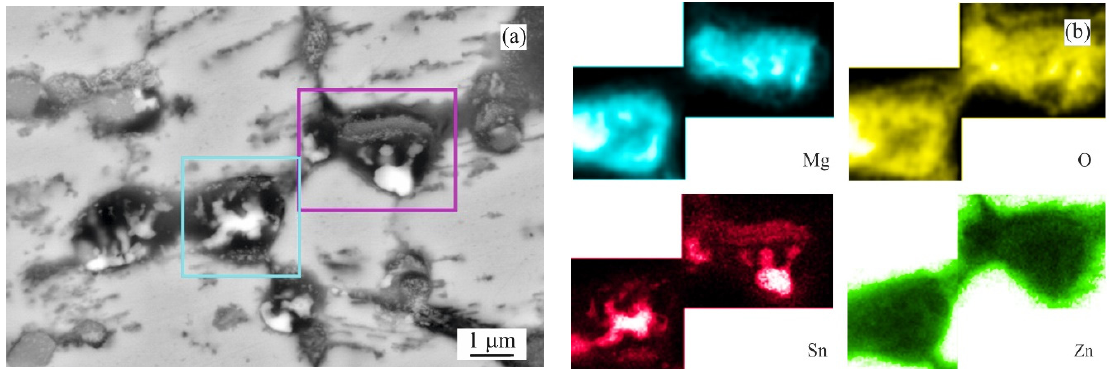
Figure 15. Details of Mg 2 Sn particles affected by dealloying (MZ + 3.0Sn, annealed): ( a ) overview BSEM image; ( b ) chemical element distribution maps of Mg, O, Sn and Zn.